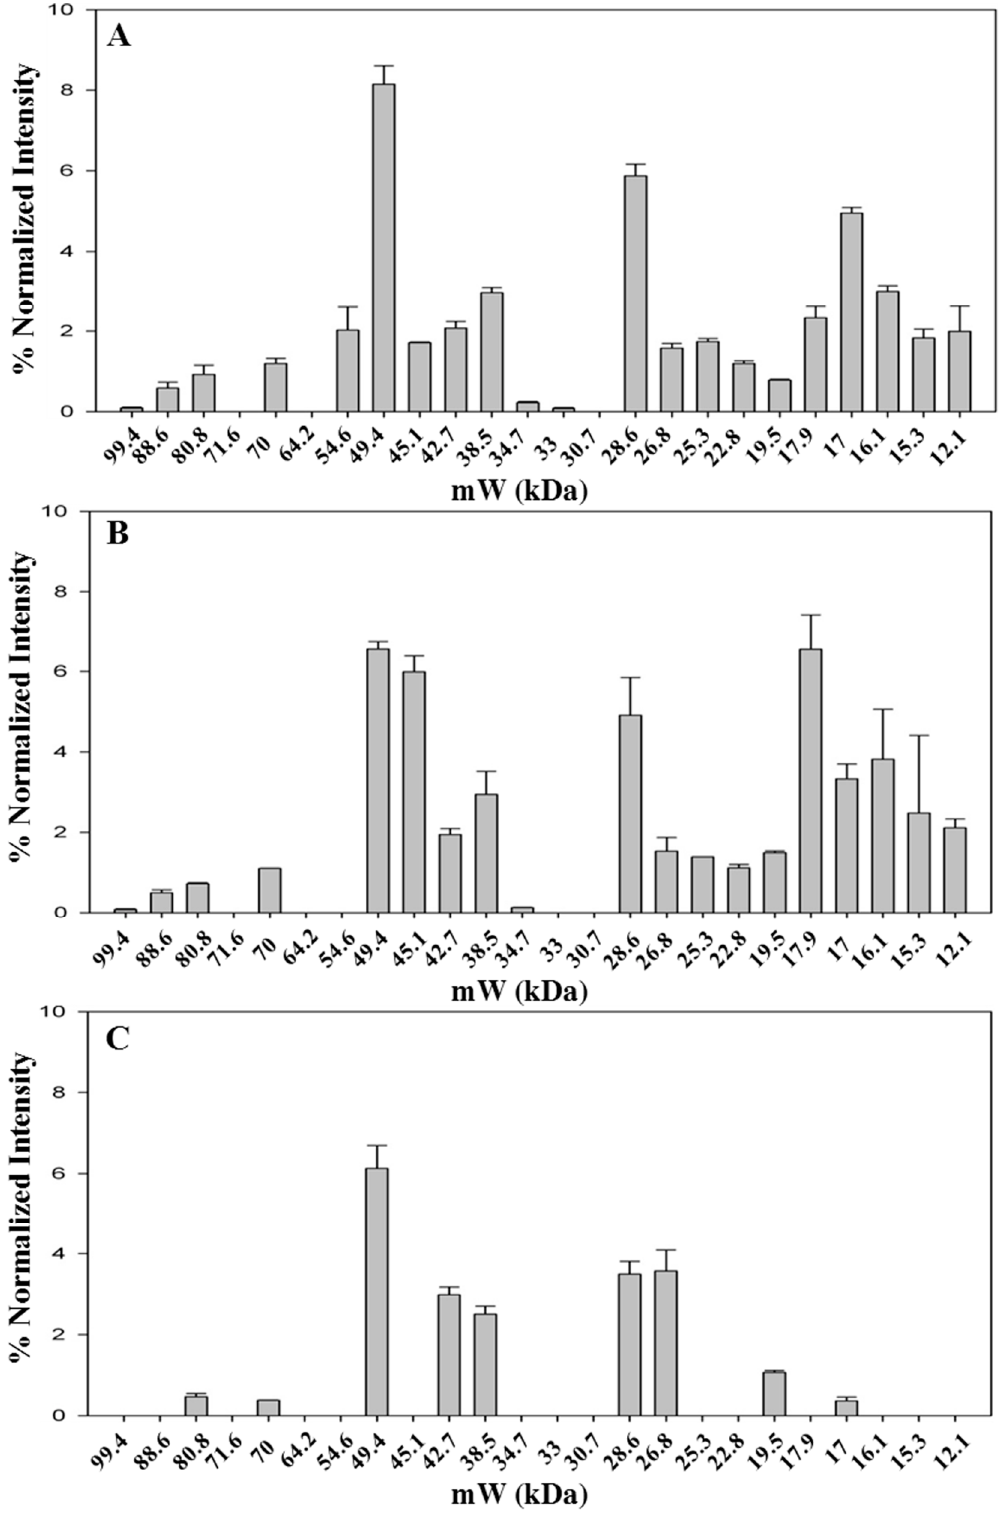
Figure 2. Bands detected in 1D-SDS-PAGE of fresh and styles stigmas ( A ); dried stigmas and styles stored for two months ( B ); and dried stigmas and styles stored for three years ( C ) after processing. Gel image was acquired with ChemiDoc™ MP System imager and analyzed with Image Lab™ software (version 5.2). Data are from two replicates.